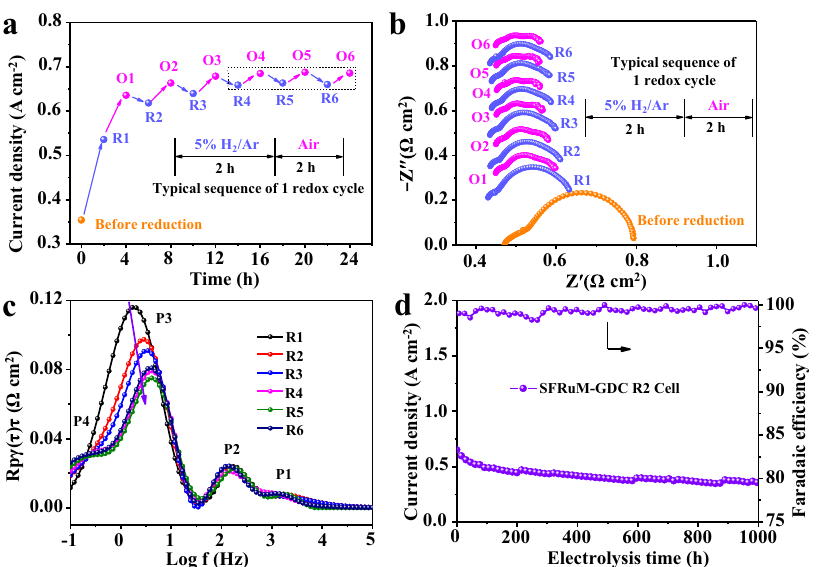
Fig. 5 Electrochemical results. a CO 2 electrolysis performance of SFRuM-GDC cell after six redox cycles at 800 °C and 1.2 V. b The corresponding in situ EIS results. c DRT spectra of the RuFe alloy NPs decorated cells calculated from b . d Stability test of SFRuM-GDC R2 cell and CO Faradaic ef fi ciencies at 800 °C and 1.2